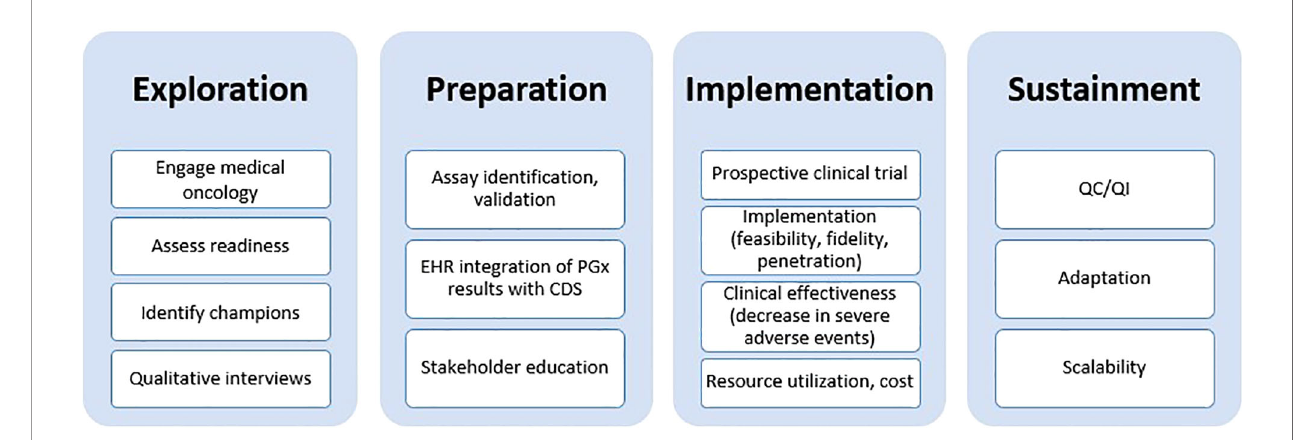
FIGURE 1 | Exploration, Preparation, Implementation, Sustainment (EPIS) framework used as a guide for implementing DPYD/UGT1A1 pharmacogenetic testing. EHR, electronic health record; PGx, pharmacogenomics; CDS, clinical decision support; QC/QI, quality